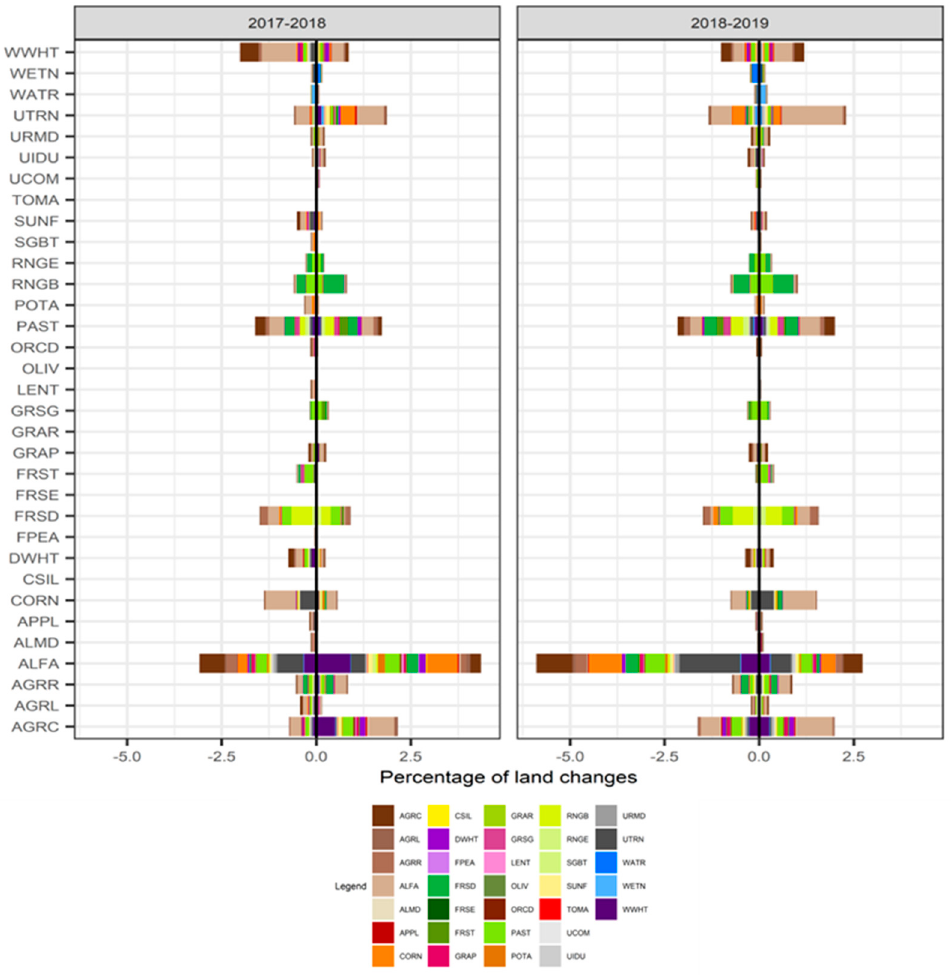
Figure 7. Land cover changes based on CNN analysis for 2017–2018 and 2018–2019.